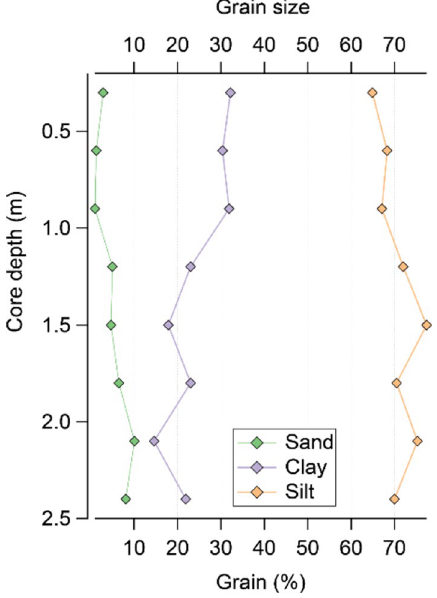
Figure 3. Grain size distribution in marine sediments (corer